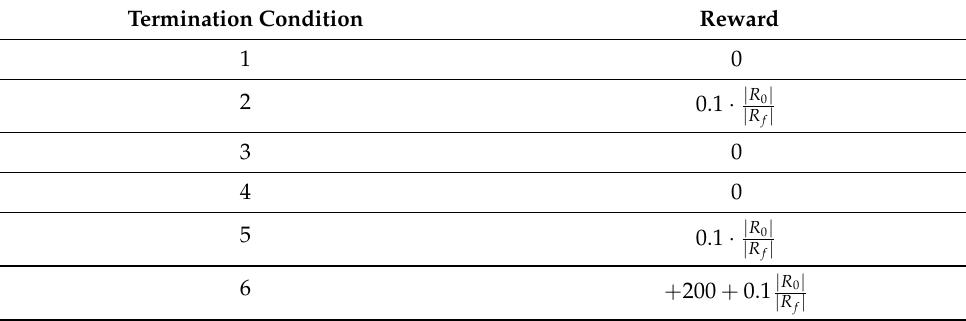
Table 8. Termination rewards for scenario B.